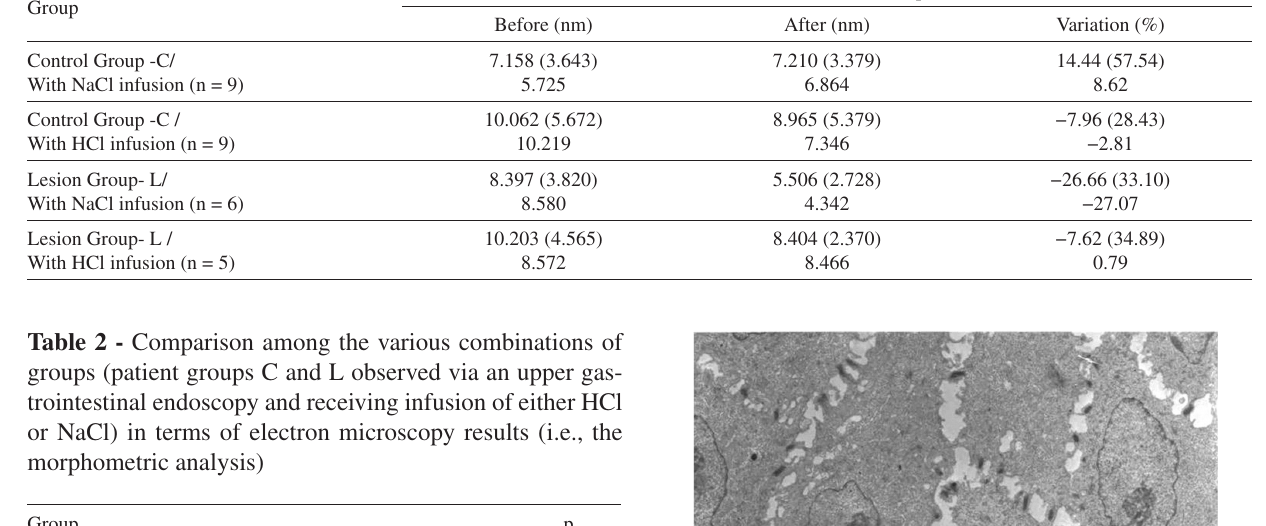
Width of the intercellular space Before (nm) After (nm)